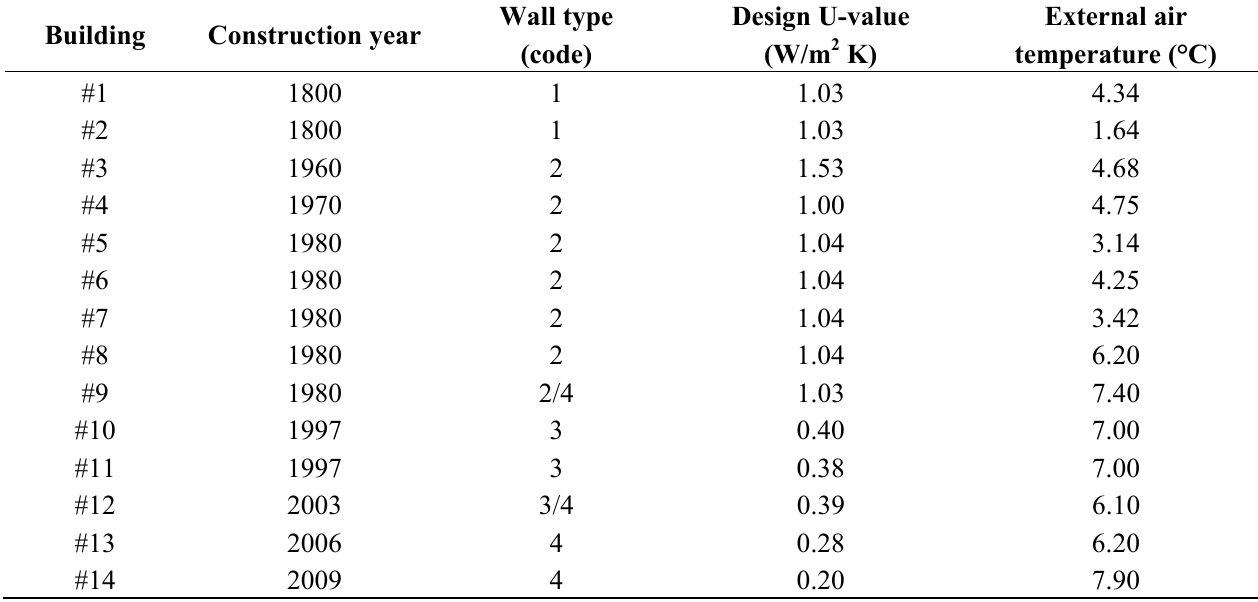
Table 2. Data for some variables recorded during the